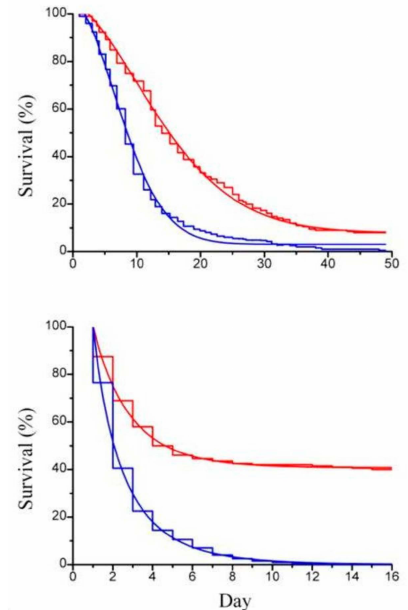
Figure5. ( a )Survivalcurve(stepline)of Artemia sp.; ( b )survivalcurve(stepline)of Artemia sp. o ff spring with the corresponding Weibull survival functions (continuous line), with paramylon (red curve) and without paramylon (blue curve), under conditions of daily medium